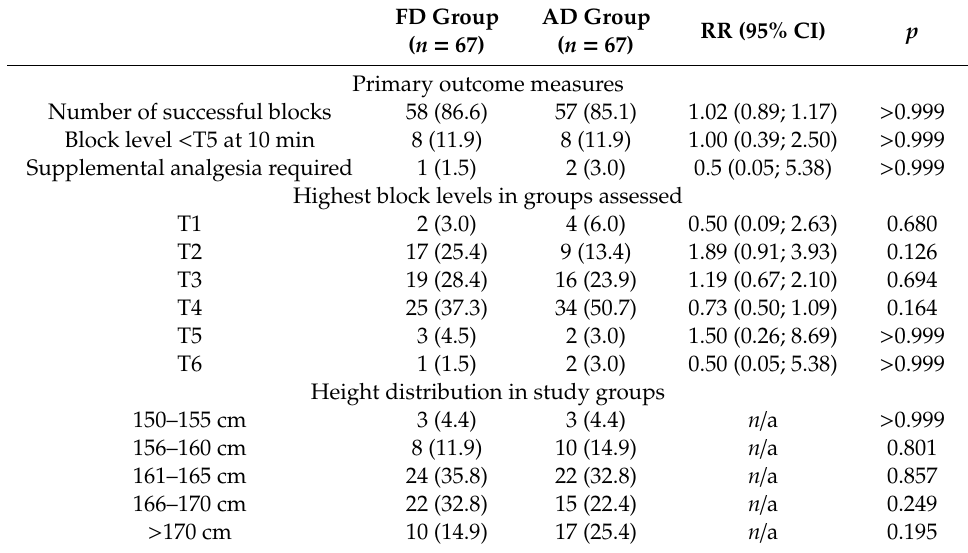
Table 3. Anaesthetic outcomes in study groups and height distribution.